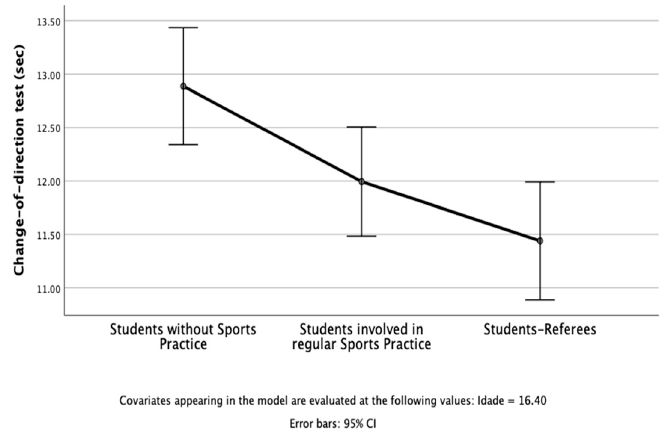
Figure 2. Students without sports practice, students involved in regular sports practice, and student referees in the change-of-direction test (seconds).